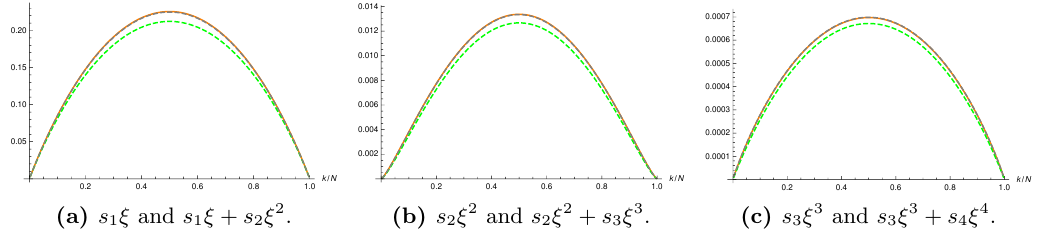
Figure 2 . Plot of 1 log W A as a function of k=N for N = 300 ; (cid:24) = 1. In (a), the orange curve N 2 k represents the exact value of 1 log W A , while the green and the gray dashed curves represent s 1 (cid:24) N 2 k and s 1 (cid:24) + s 2 (cid:24) 2 , respectively. In (b) and (c), we show the plot of 1 log W A (cid:0) s 1 (cid:24) and 1 log W A (cid:0) N 2 N 2 k k s 1 (cid:24) (cid:0) s 2 (cid:24) 2 , respectively. Again, the orange curve is the exact value, while the green and the gray dashed curves represent the next order term and the sum of the next and the next-to-next order terms,